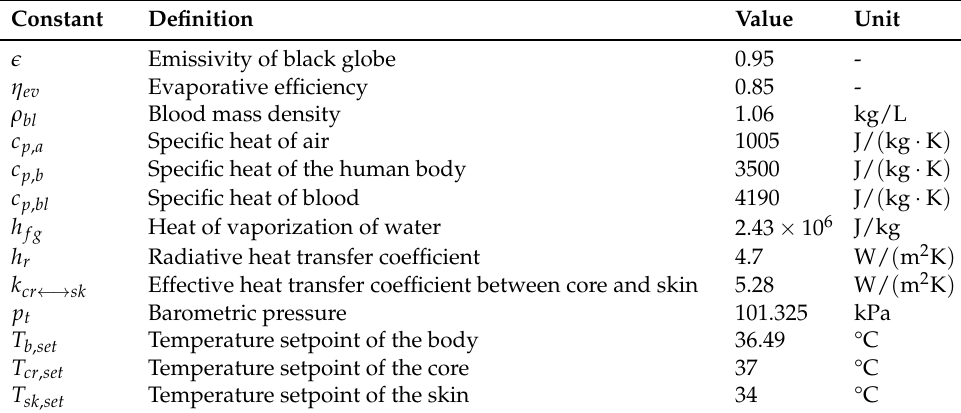
Table A1. Constants for the computation of TSENS and DISC.